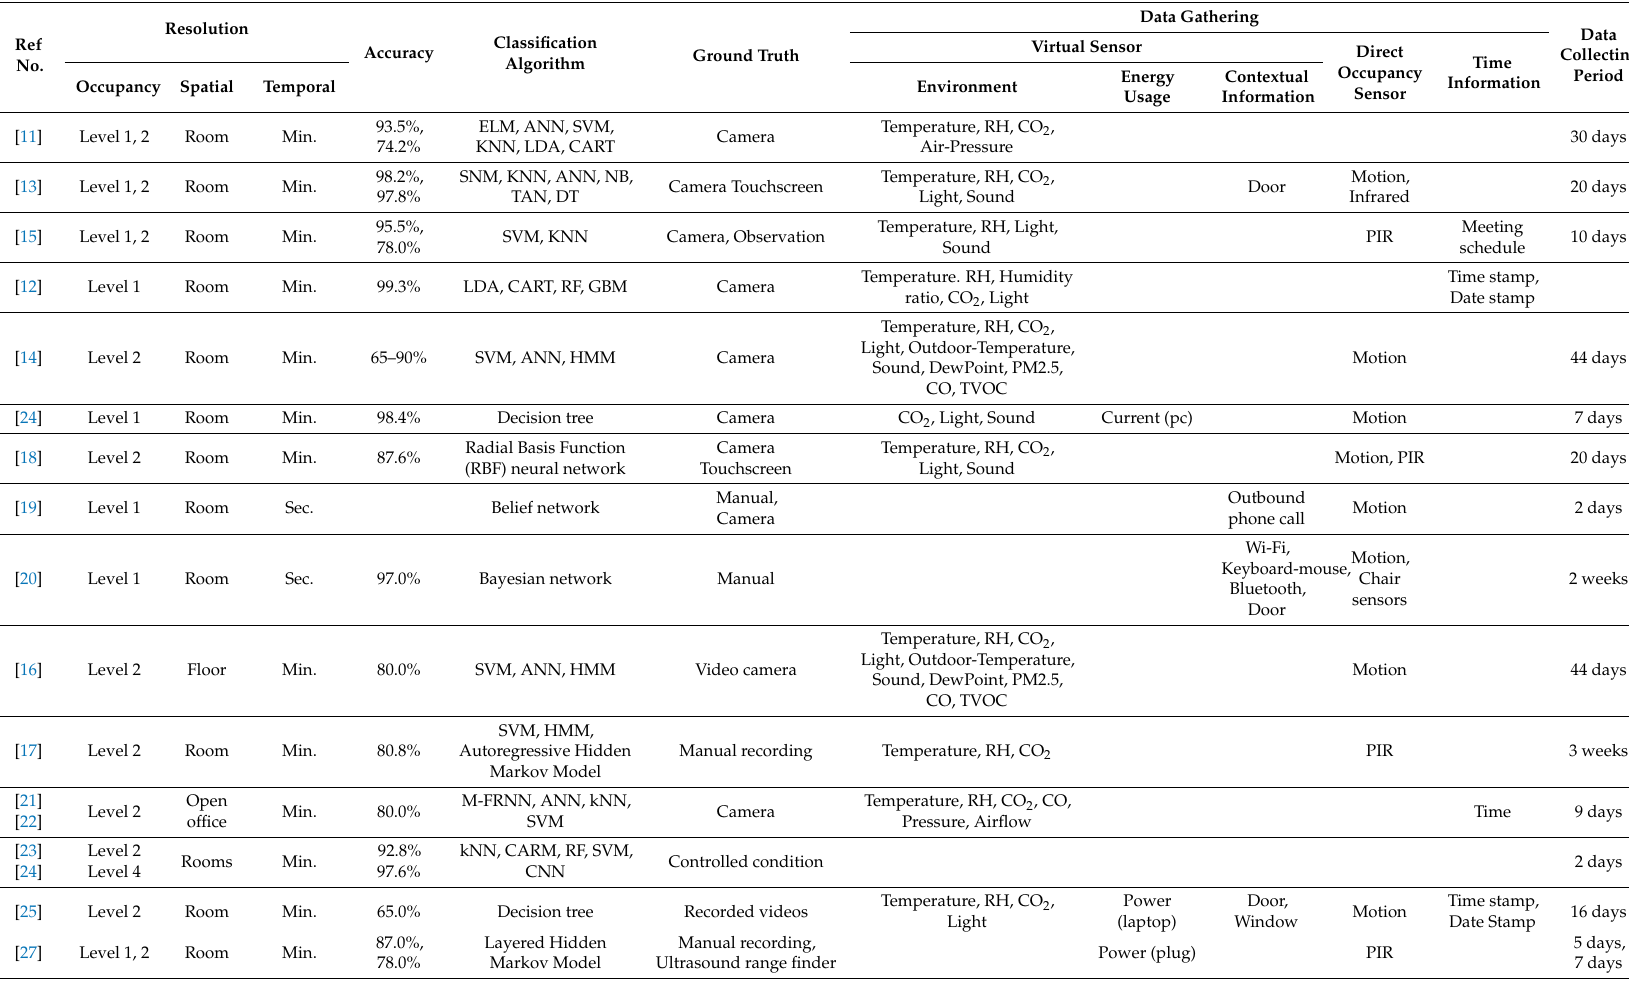
Table 1. Summary of occupancy estimation studies in terms of input data gathering methods, time/spatial resolutions, classification algorithms, data gathering methods for ground truth, and estimation accuracies. Ref